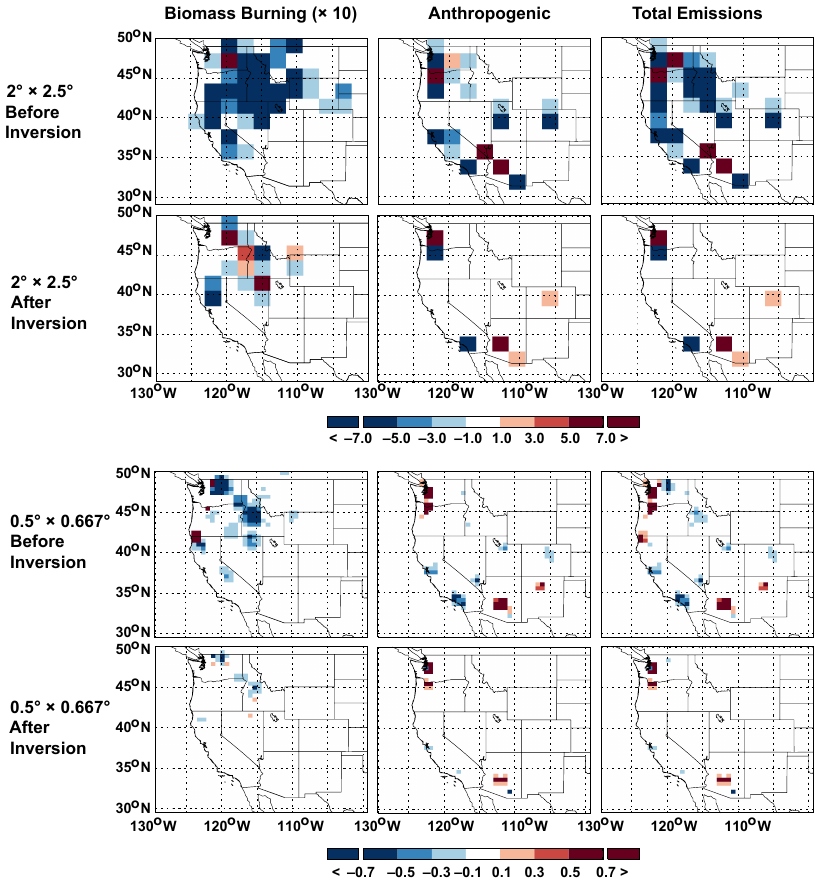
Figure 3. Normalized sensitivities of the cost function with respect to the BC emissions (left: biomass burning BC; middle: anthropogenic BC; right: total emissions of BC) before and after the inversions at 2 ◦ × 2.5 ◦ (Case 1, Table 1) and 0.5 ◦ × 0.667 ◦ (Case 9, same as Case 1, except at 0.5 ◦ × 0.667 ◦ ) for August 2006. For the purpose of clarity, sensitivities of the cost function to biomass burning emissions are multiplied by 10 in the